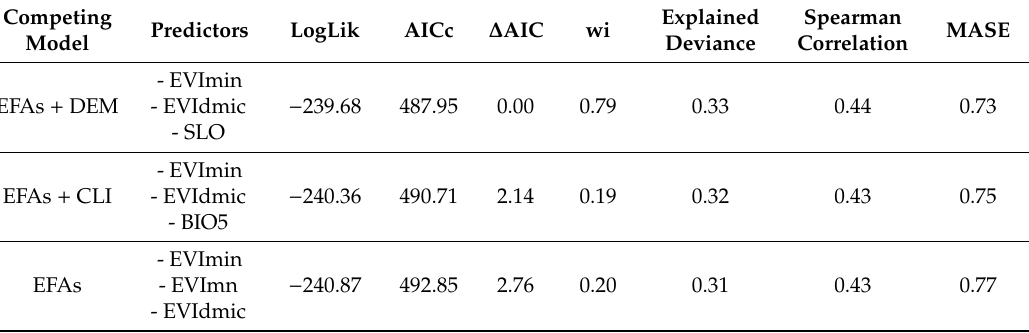
Table 1. Results from the generalized linear models (GLM) model selection and multi-model inference explaining local abundance patterns of Iris boissieri . The competing models are listed in descending order from the best to least fitted model determined by their mean absolute scaled error (MASE) values. For comparison, a baseline ‘null model’ containing a single intercept term is used. Loglik: loglikelihood. AICc: Akaike Information Criterion value. ∆ AICc: represents the di ff erences between the AICc values of the best model considered and other competing models. wi: represents the Akaike weights and indicates the probability that a particular model is the best among those considered. Explained deviance: the proportion of the explained deviance by the model. Spearman Correlation: Spearman correlation between observed and predicted values. MASE: Mean absolute scaled error as a measure of the predictive accuracy, and ranges from 0 = highest accuracy, to 1 = lowest